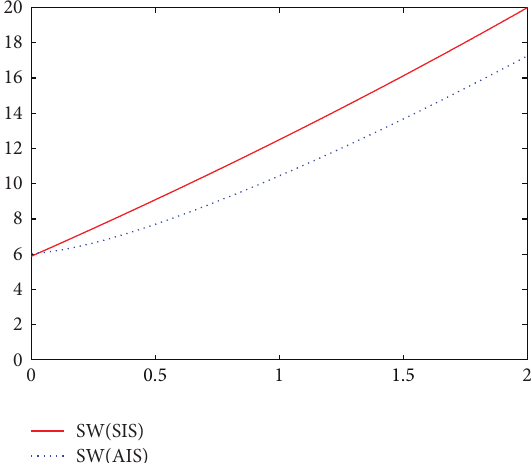
Figure 9: Social welfares with innovation subsidies.